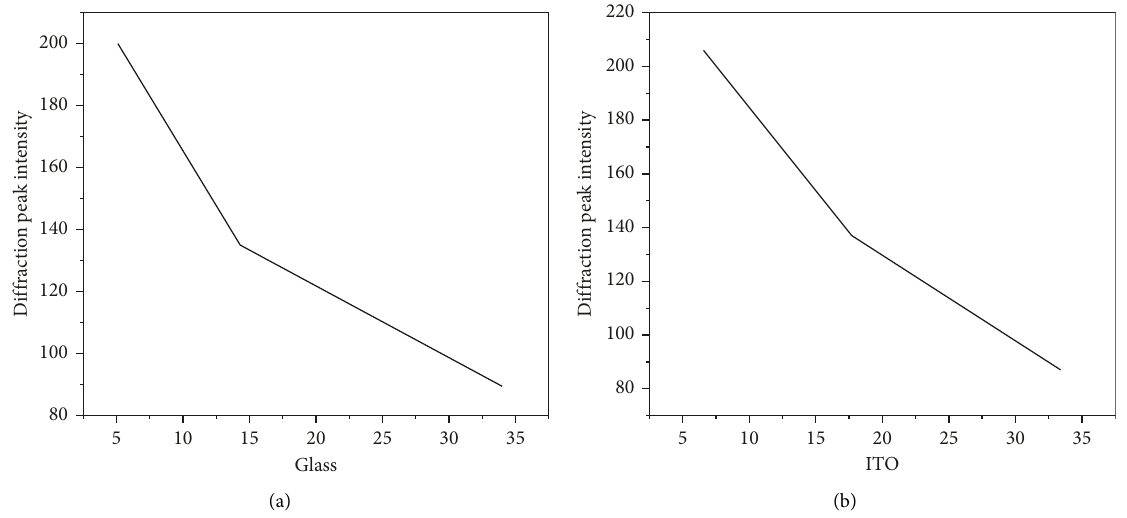
Figure 3: XRD patterns of PMPI3 films treated at different temperatures. (a) PMPI